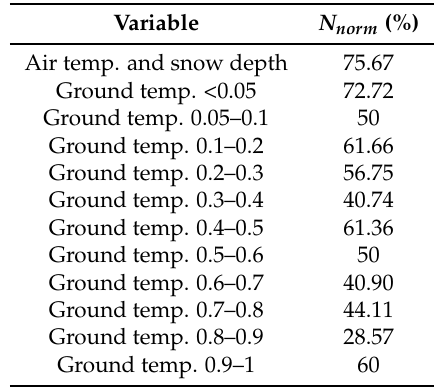
Table 4. Results of the normality test of the residuals for the ANCOVA analysis (air temperature, snow depth, ground temperature (for the different depth groups in m)). N norm gives the relative number of occurrences (normalized by the total number of sites relevant for this parameter), for which the deviation from normality is significant at α = 0.01.